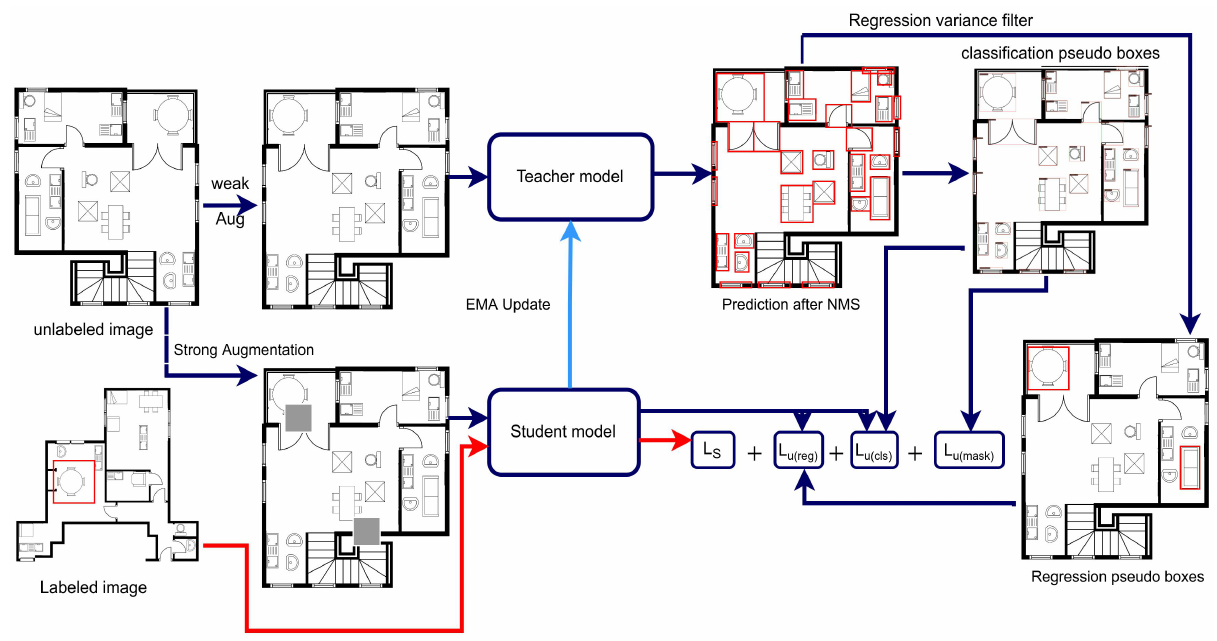
Figure 4. The complete architecture of the semi-supervised approach. The red arrows show the supervised, and dark blue arrows show unsupervised training. The total loss is the combination of unsupervised and supervised